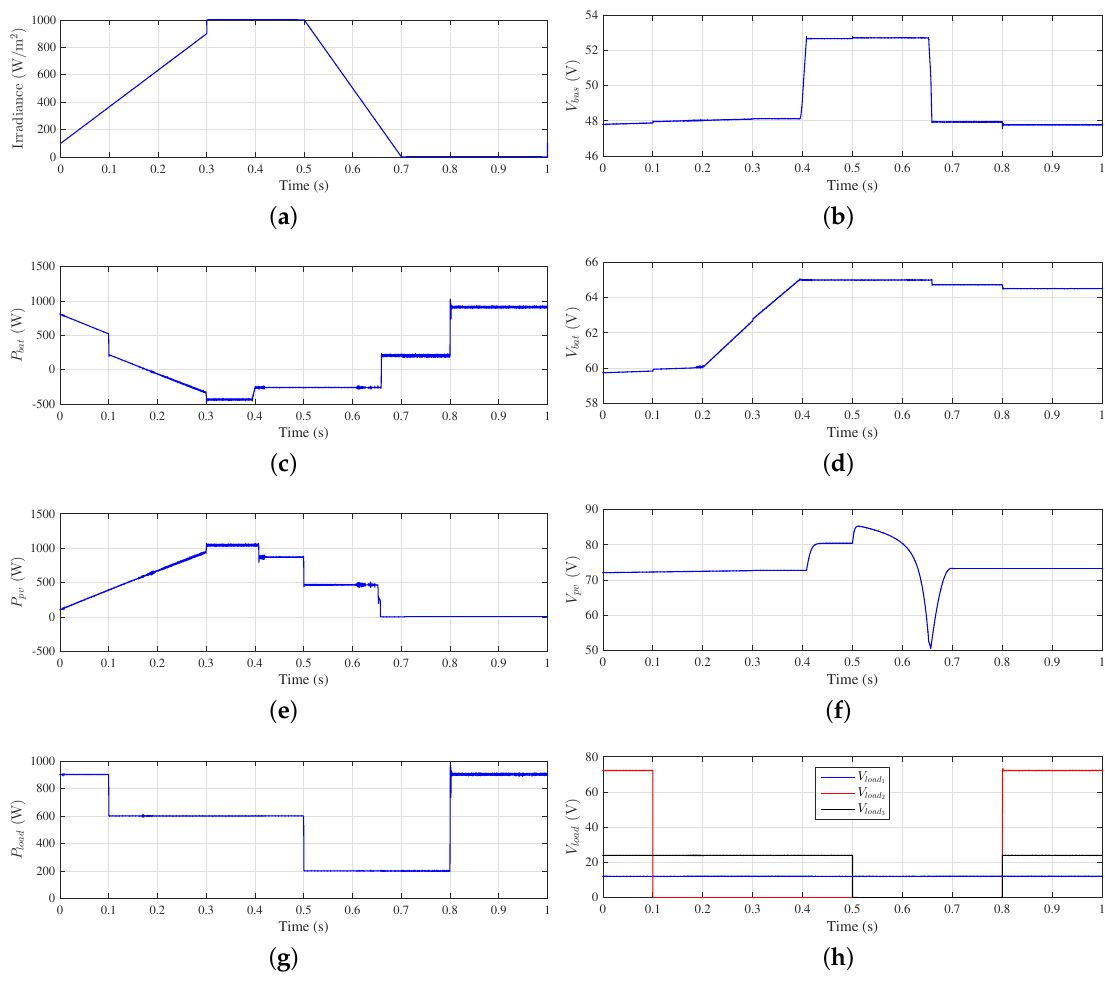
Figure 20. Simulation results. ( a ) Solar irradiance variation. ( b ) DC bus voltage V bus . ( c ) Total charging/discharging power P bat of the two battery packs. ( d ) Battery voltage V bat . ( e ) Total power generation P pv of the three PV arrays. ( f ) PV array voltage V pv . ( g ) Total load power P load . ( h ) Voltages V load at three load 1,2,3